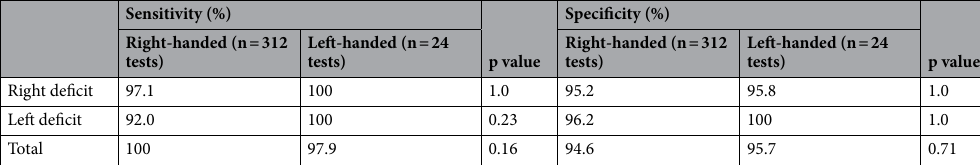
Table 2. Effect of body laterality on HIT performances. Left-handed group comprised 2 novices and one expert and the right-handed group included 33 novices and 6 experts. For the novice group, only the performances at the final test were analyzed. Comparisons between left-handed and right-handed groups were conducted by a Fisher’s exact